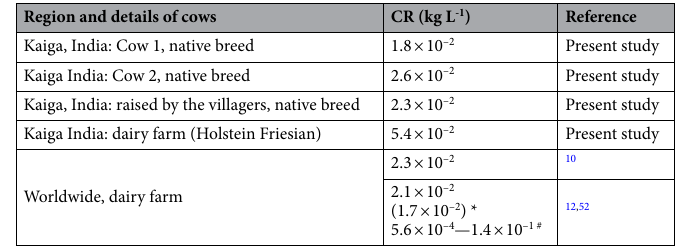
Table 7. CR values for Sr. *Value in the parenthesis is GM value, and others are arithmetic mean. # Represents the